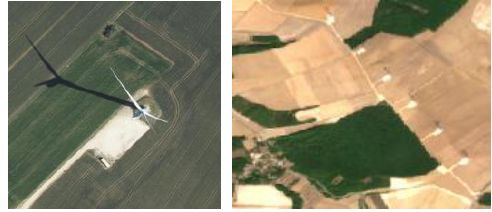
Figure 1 . One windmill on a VHR image (Geoportail © IGN) at full resolution and six aligned windmills on a Sentinel-2 image at full resolution.